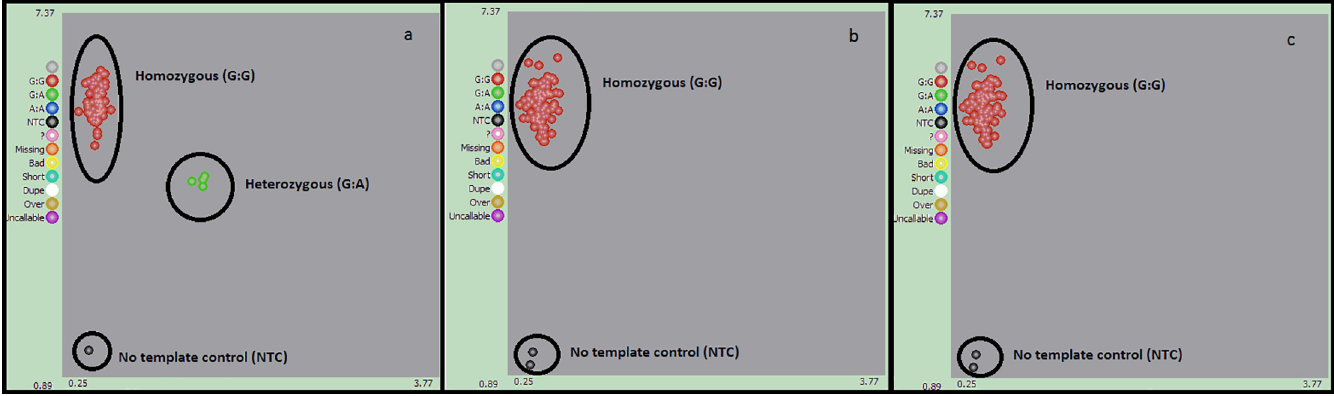
Fig 1. KASP assay cluster plots of the p.G2019S (rs34637584). Genotypes cluster are visualised using SNP Viewer software. Samples marked red are p.G2019S homozygous (G:G), those marked green are p.G2019S heterozygous (G:A) and those marked black are non-template control (NTC). Plot (1-a) shows two distinctive clusters: the red cluster obtained from samples known to be homozygous (G;G) and the green cluster obtained from samples known to be heterozygous (G:A). Those samples with known genotypes were used to validate the assay prior to running the test samples. No known p.G2019S homozygous (A:A) sample was available to be included. Plots(1-b) and (1-c) show the data from the Nigerian cohort. All PD patients and controls are homozygous for the normal p.G2019S allele (G:G).